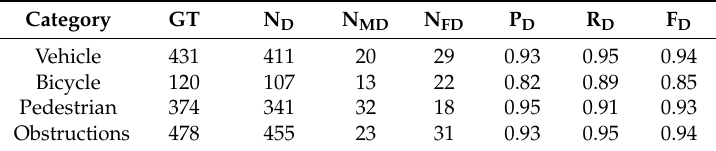
Table 5. Experimental evaluation of the overall obstacle detection architecture.